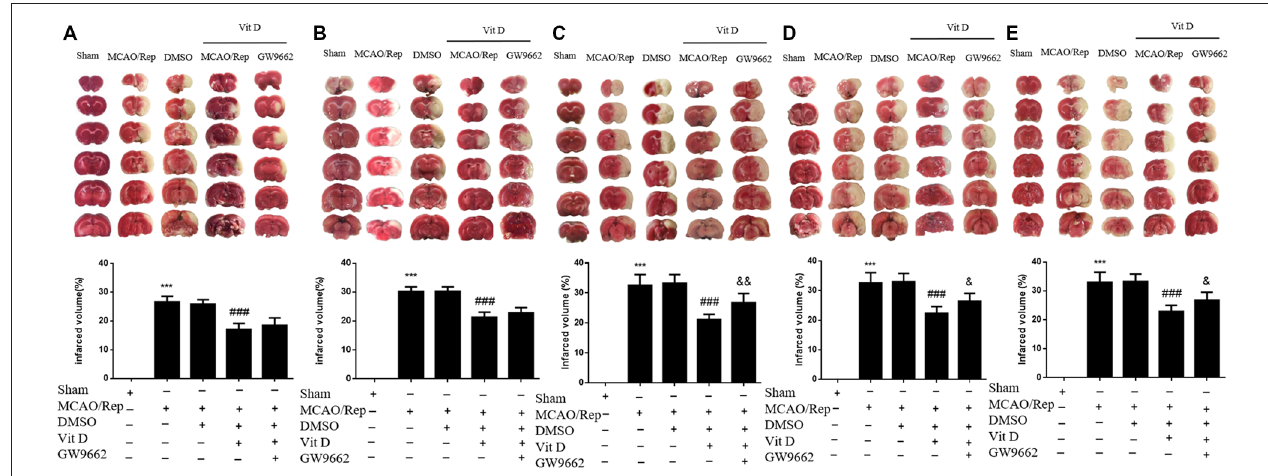
FIGURE 2 | 1, 25-D 3 (Vit D) decreased the infarct volume. (A–E) Rat brains were sliced and stained with 2,3,5-triphenyltetrazolium chloride (TTC) at the 6 h, 12 h, 24 h, 3 days and 5 days after MCAO/R and the percentage of relative infarct volume was calculated. Data are represented as Mean ± SEM, n = 6, ∗∗∗ P < 0.001 vs. sham group, ### P < 0.001 vs. DMSO, && P < 0.01 vs. 1, 25-D 3 group, & P < 0.05 vs. 1, 25-D 3 group. MCAO/R, middle cerebral artery occlusion/reperfusion; DMSO, dimethyl sulfoxide; PPAR- γ , peroxisome proliferator-activated receptor-gamma; 1, 25-D 3 , 1, 25-dihydroxyvitamin D 3 ; GW9662, inhibitor of PPAR- γ .